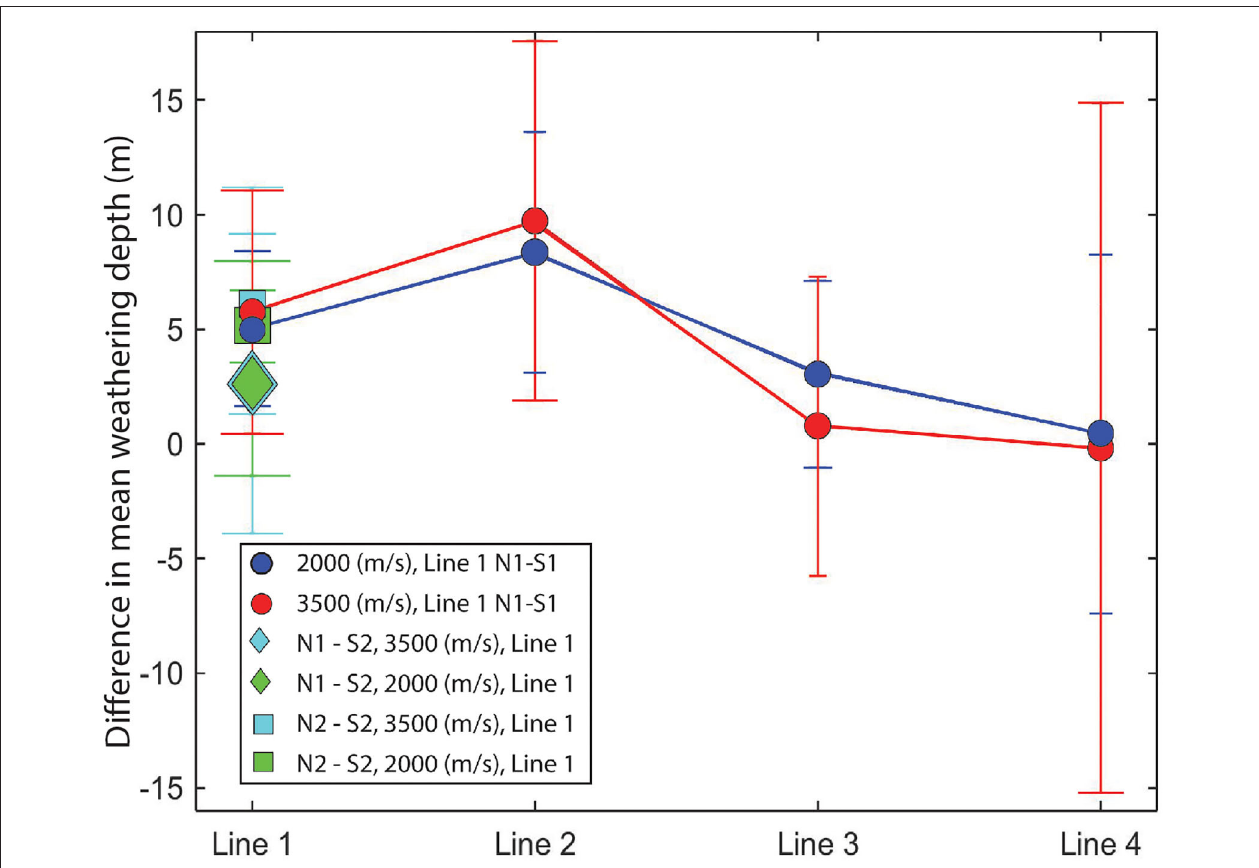
FIGURE 12 | The N–S weathering depth asymmetry, i.e., the difference in mean depth to fractured (2,000 m/s) and fresh (3,500 m/s) bedrock between the north and south facing slopes. Because Line 1 spans two catchments there are two sets of hillslopes to analyze: they are shown as circles for the difference between hillslopes N1 and S1, diamonds for hillslopes N1 and S2, and squares for hillslopes N2 and S2. The highest N-S weathering depth asymmetry occurs at Line 2; above and below this the asymmetry